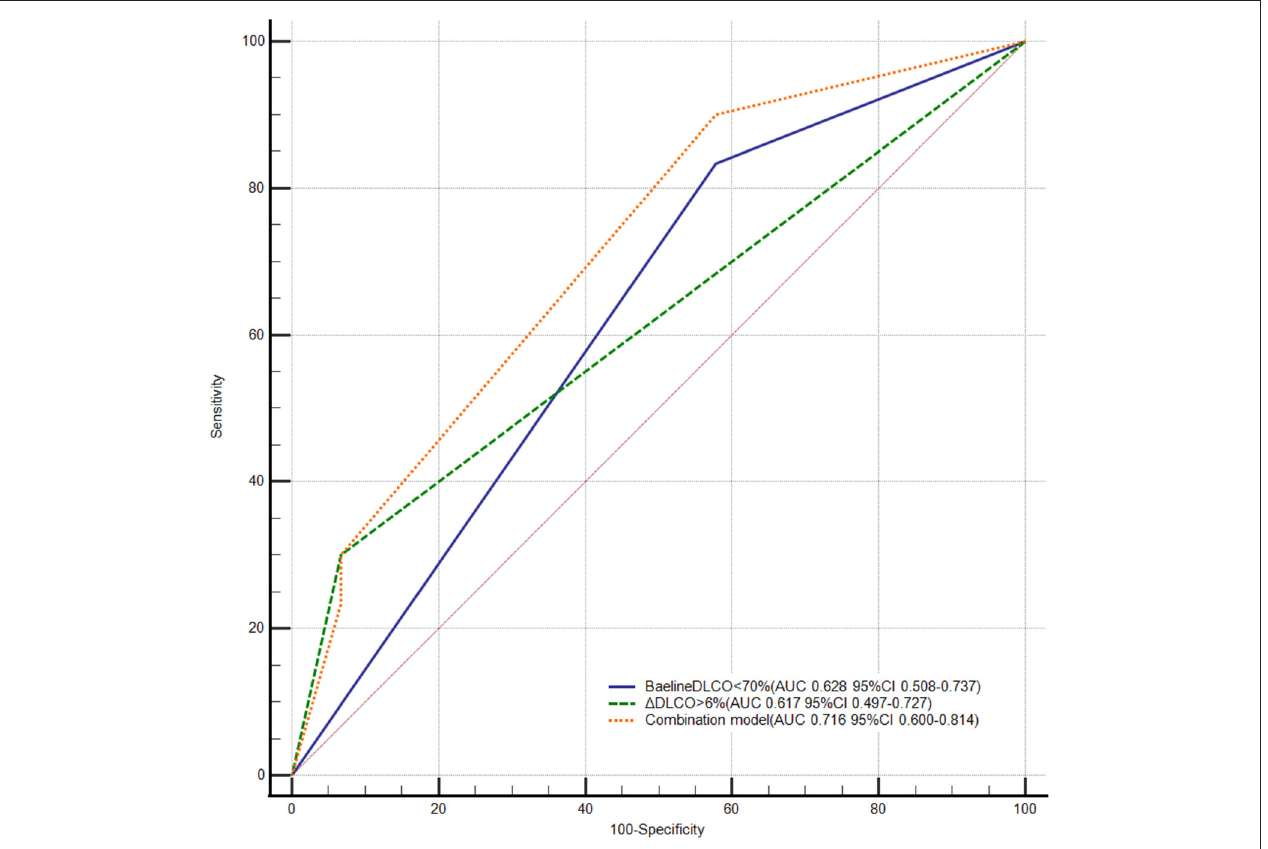
FIGURE 3 | Receiver operator characteristic curve of DLCO in predicting unfavorable response to BPA. BPA, balloon pulmonary angioplasty; DLCO, diffusing capacity for carbon monoxide; 1 DLCO, the percent change of DLCO between the baseline and within 7 days after the first BPA session. DeLong test pairwise